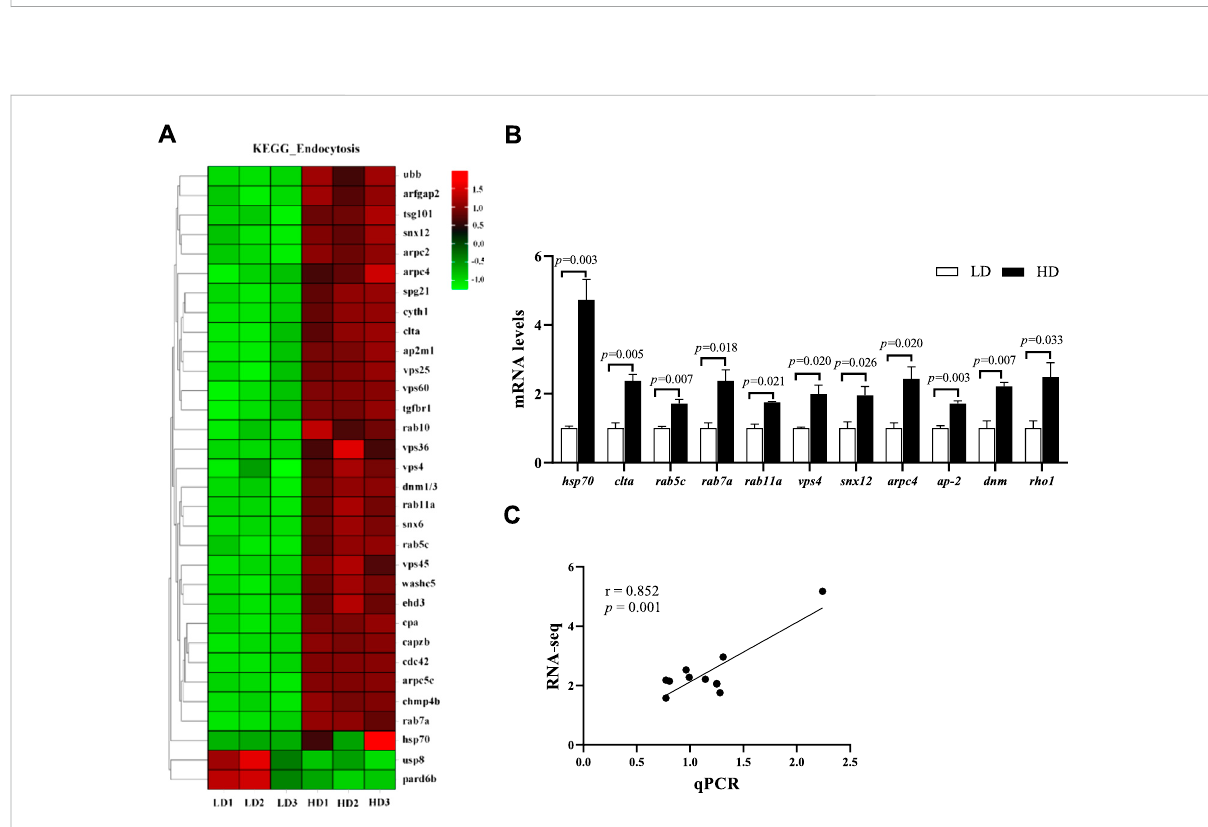
FIGURE 7 Changes of endocytosis pathway in the hepatopancreas of C. quadricarinatus between the LD group and the HD group. (A) DEGs enriched in endocytosis pathway. (B) Endocytosis-related gene expression measured by qPCR, values are presented as means ± SE ( n = 3). (C) The correlation between the qPCR data and RNA-seq